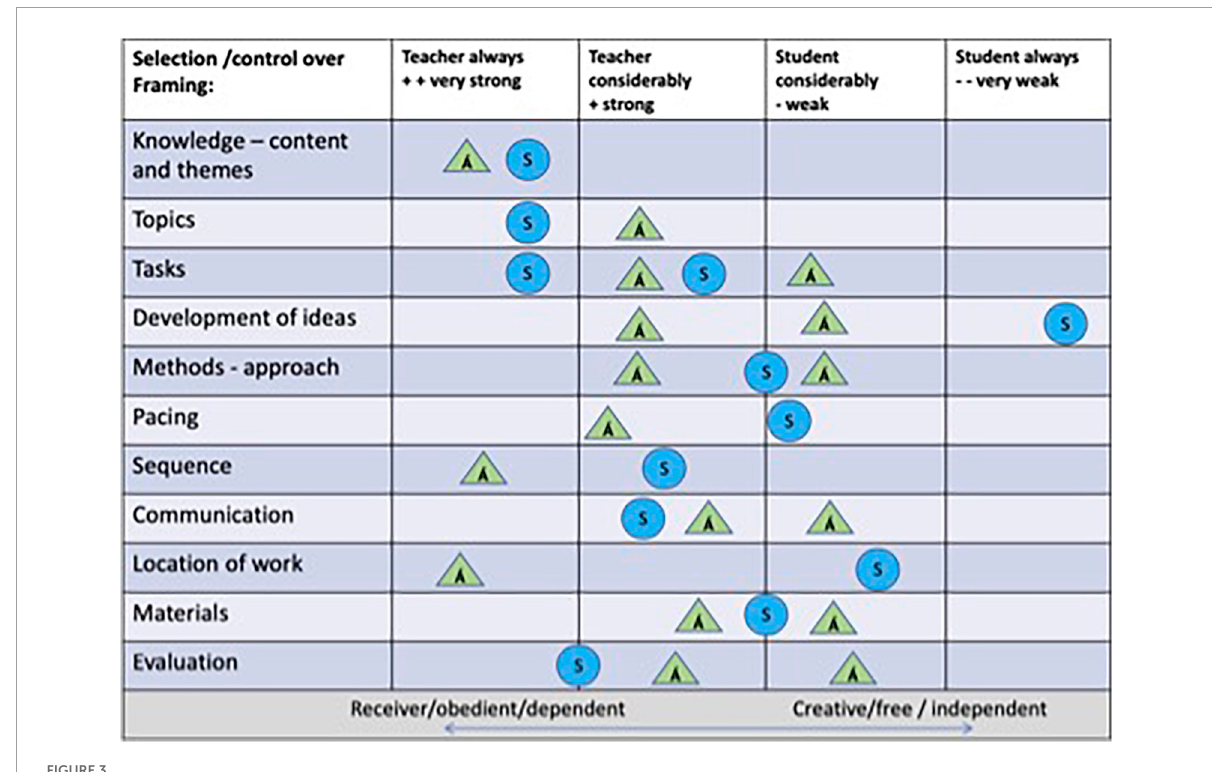
FIGURE3 Ása Helga’s and Sverri’s